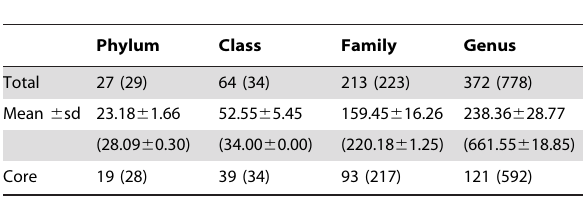
Table 1. Taxonomic profiles of the porcine colon